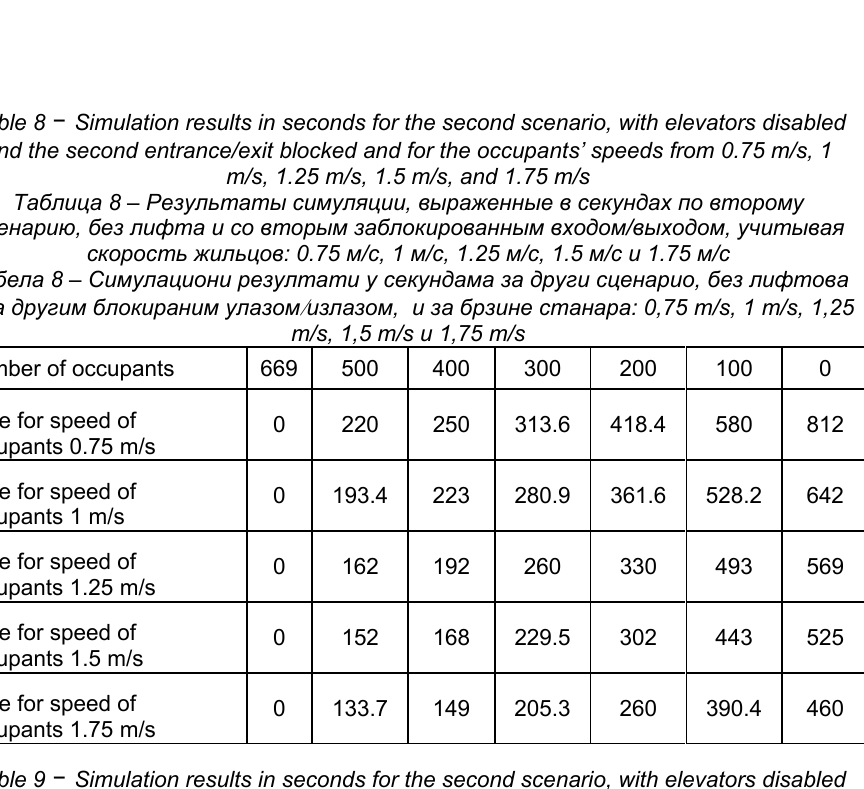
Table 9 – Simulation results in seconds for the second scenario, with elevators disabled and the third entrance/exit blocked and for the occupants’ speeds from 0.75 m/s, 1